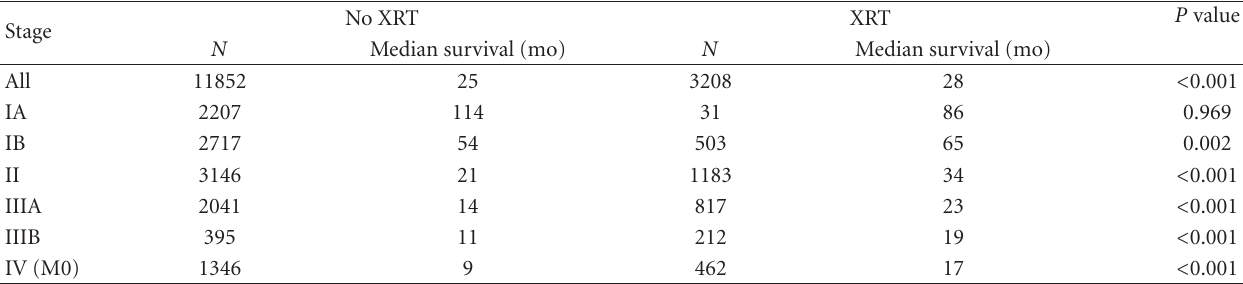
Table 2: Overall survival by